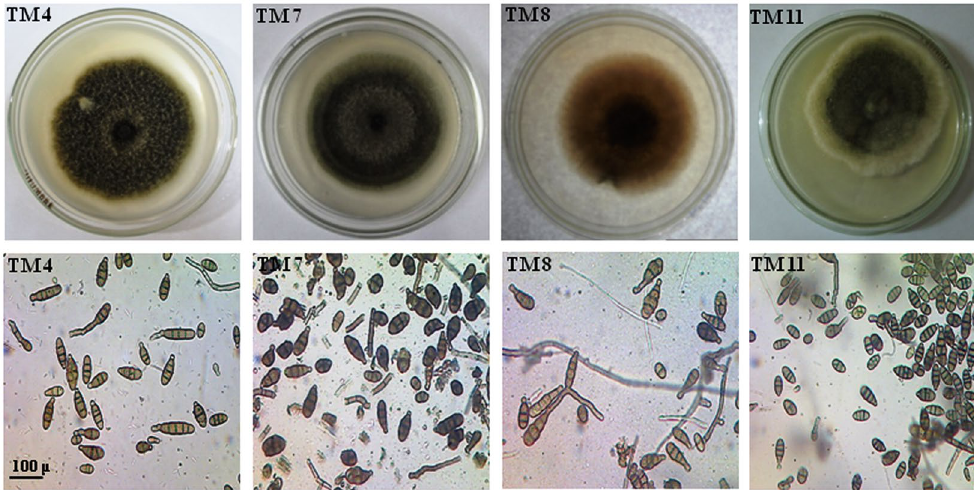
Figure 1. Morphological characteristics, growth pattern, colony morphology and microscopic examination of three potent toxic isolates of Alternaria species collected from different regions in India. All the Alternaria isolated were grown on PDA culture media and incubated at 28 °C for 12 h light/dark photoperiod. The pictures of the colonies were taken at 6 th day after incubation of pathogen. Note: The names of the Alternaria isolates were given as abbreviation of the different plants from which they were isolated (details described in Table